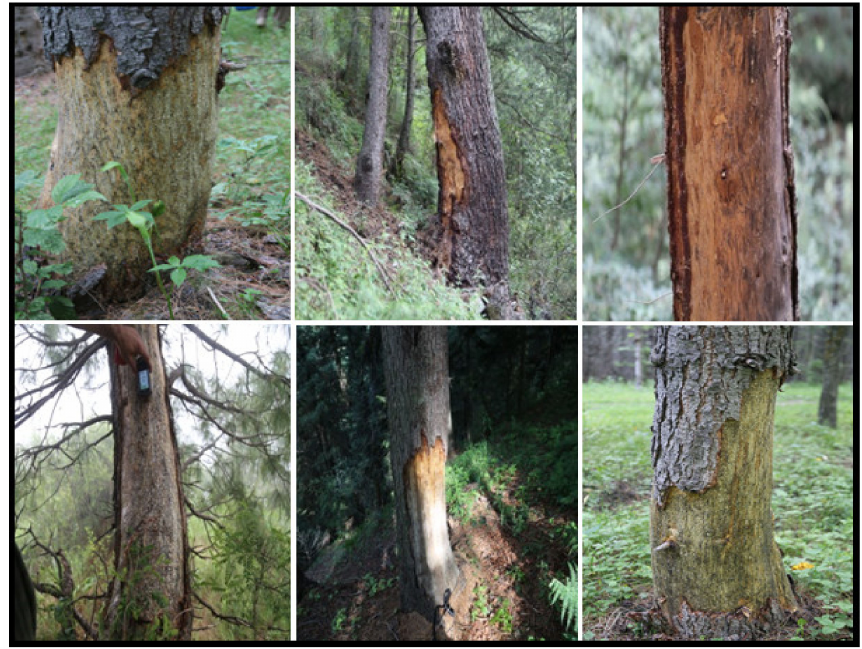
Figure 2. Photos of Pinus wallichiana damages in Kaghan Valley, Pakistan. Table 2. Summary of the Himalayan white pine ( Pinus wallichiana ) damages with help of transects and DBH methods. ForestZone Area(ha)